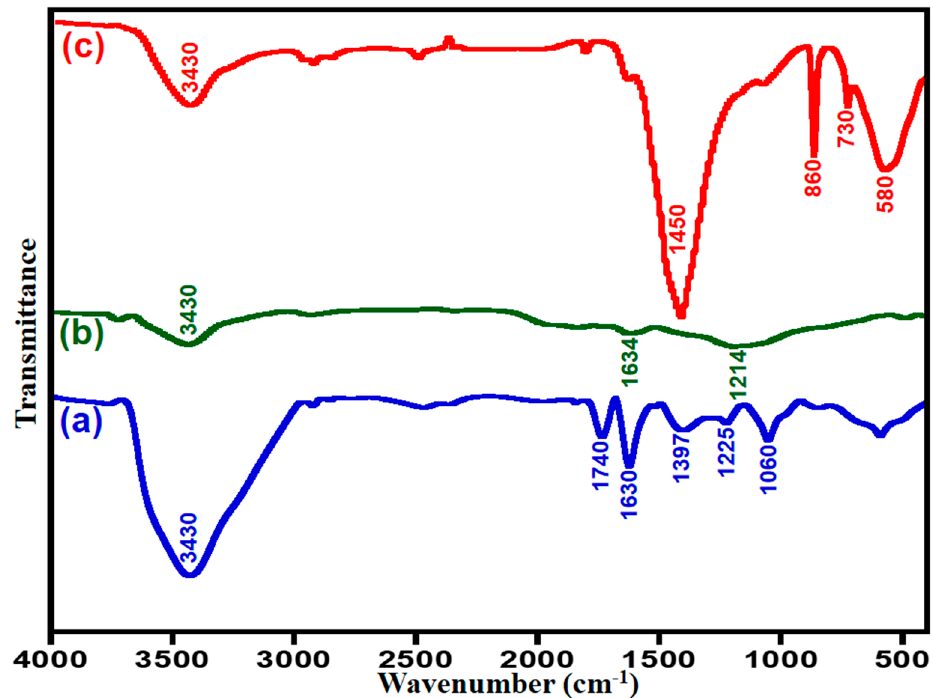
Figure 3. FT ‐ IR spectra of ( a ) GO; ( b ) HRG; and ( c ) ZnO x (1%)–MnCO 3 /(1%)HRG nanocomposite.